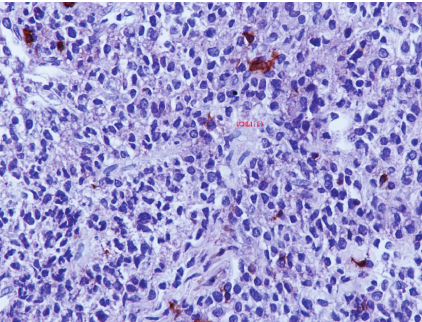
Figure 2: To the right, indicated uninvolved liver. To the left, atypical large lymphoid infiltrates at edges of portal tract, with disruption of hepatic parenchyma (H-E 40).